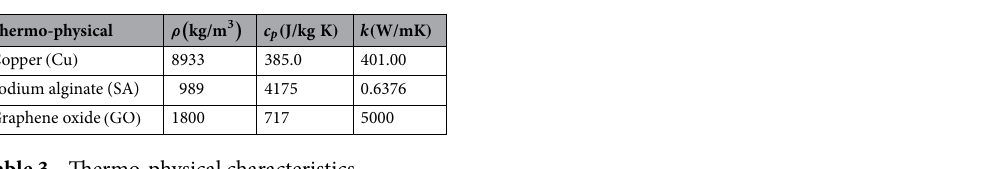
Table 3. Thermo-physical